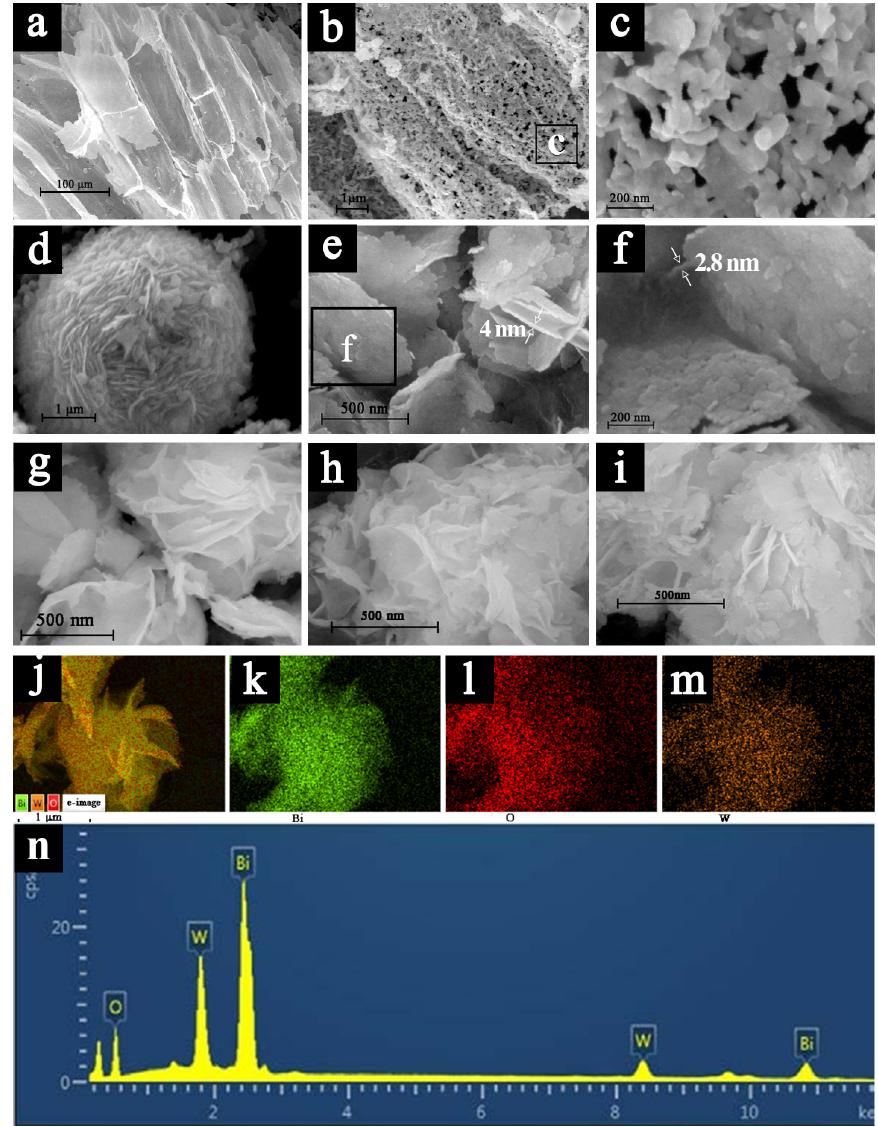
Figure 2. FESEM images of SSBT-Bi 2 O 3 at different resolutions ( a – c ) and pure Bi 2 WO 6 ( d ); SEM images with increasing resolution of 1:8 Bi 2 WO 6 /Bi 2 O 3 ( e , f ), and 1:10 Bi 2 WO 6 /Bi 2 O 3 , 1:8 Bi 2 WO 6 /Bi 2 O 3 , and 1:6 Bi 2 WO 6 /Bi 2 O 3 ( g – i ); mapping of 1:8 Bi 2 WO 6 /Bi 2 O 3 ( j – m ) and the corresponding EDX ( n ). Note: ( c , f ) are enlargements of the boxed areas in ( b , e